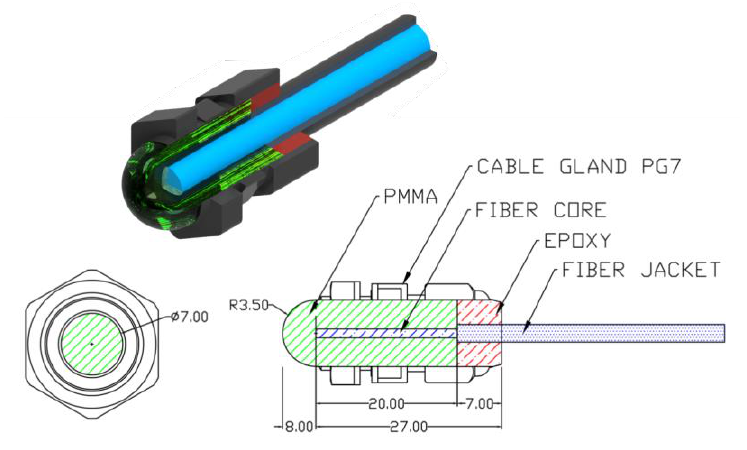
Figure 1. Cross sections of the mechanical structure of the active optical lens made of PMMA, poly(methyl methacrylate).